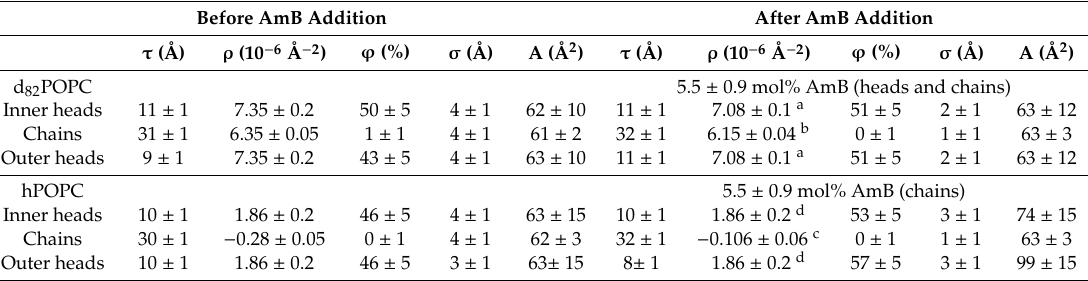
Table 2. Parameters corresponding to the best fit to the data from d 82 POPC and hPOPC membranes before and after the addition of AmB addition, as displayed in Figure